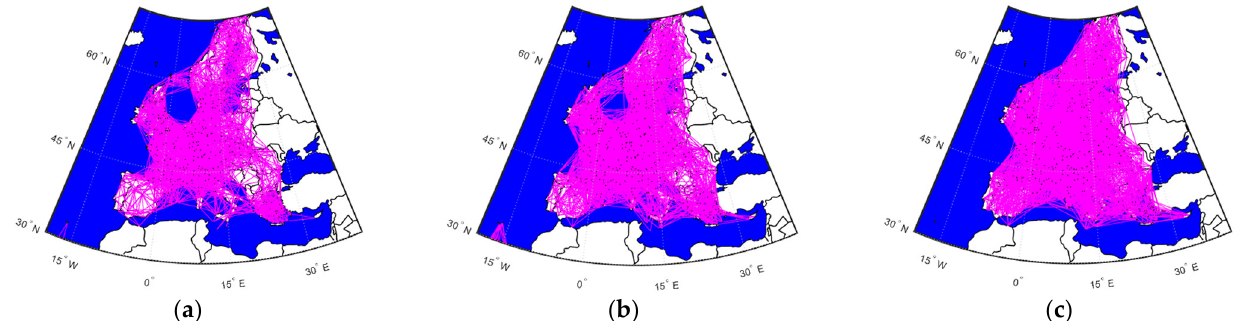
Figure 5. Connections between commercial airports in operation in different distances ( a ) 350–500 km, ( b ) 500–650 km, and ( c ) 650–800 km.